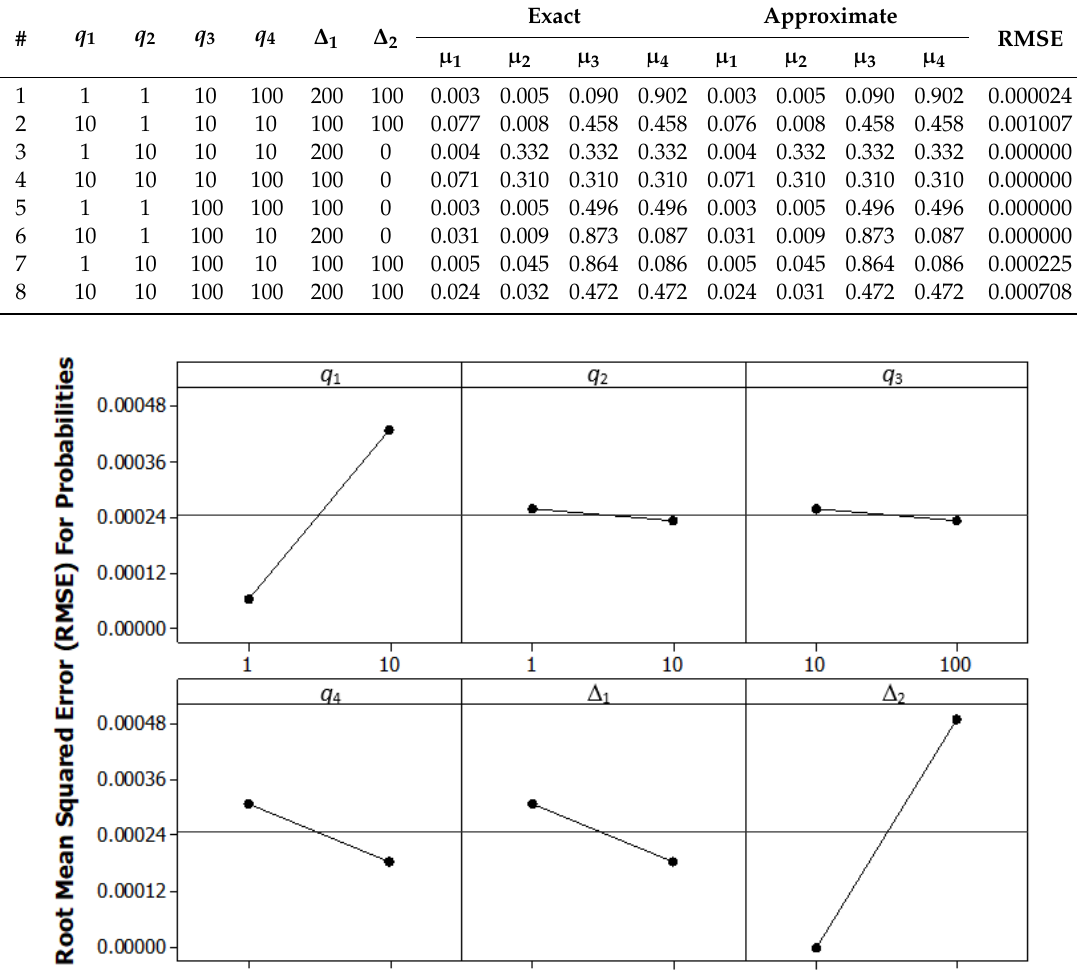
Table A1. Eight cases with the exact posterior probability and the approximate values.